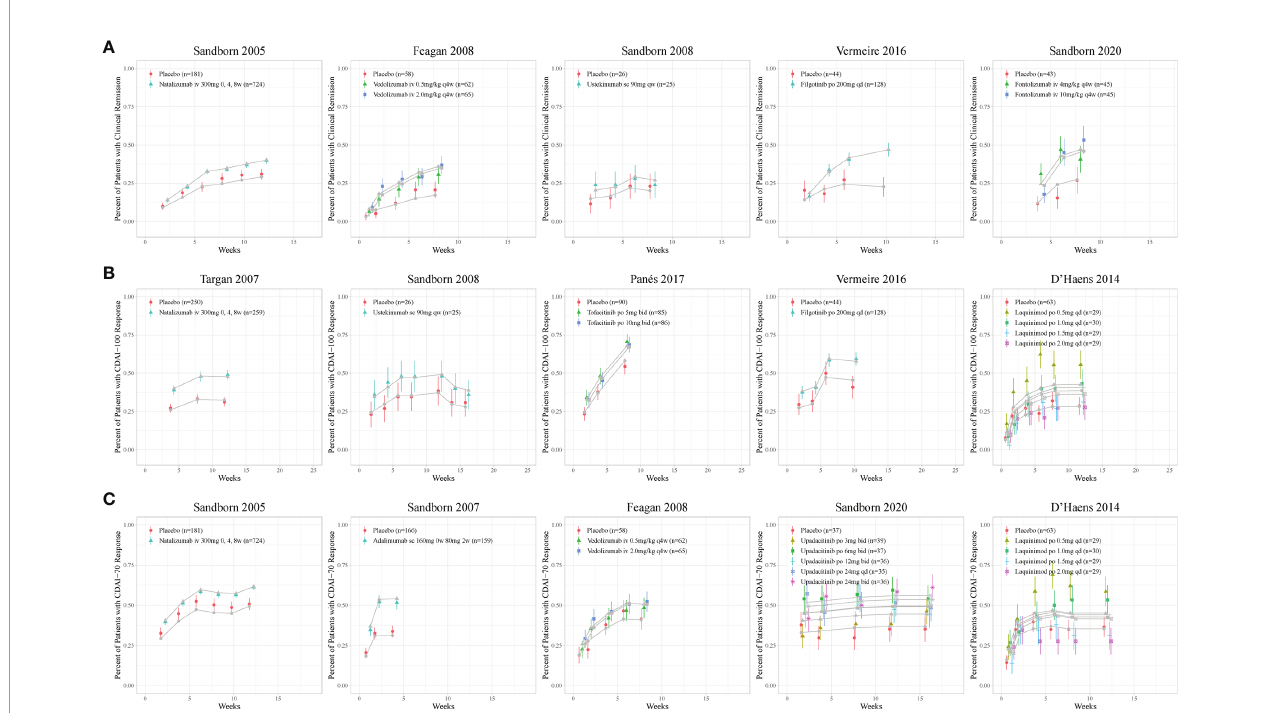
FIGURE 2 | Model fi tted time-course plots of response rate for (A) CDAI150, (B) CDAI-100, and (C) CDAI-70 for representative trials. Color symbols and vertical bars are observed mean and calculated weight of time points; gray symbols and lines are the model predictions. CDAI, Crohn ’ s Disease Activity Index; CDAI150, an absolute CDAI score of less than 150; CDAI-100, reduction of at least 100 points in the CDAI score; CDAI-70, reduction of at least 70 points in the CDAI score; qd, once daily; bid, twice daily; qw, once weekly; q4w, once every 4